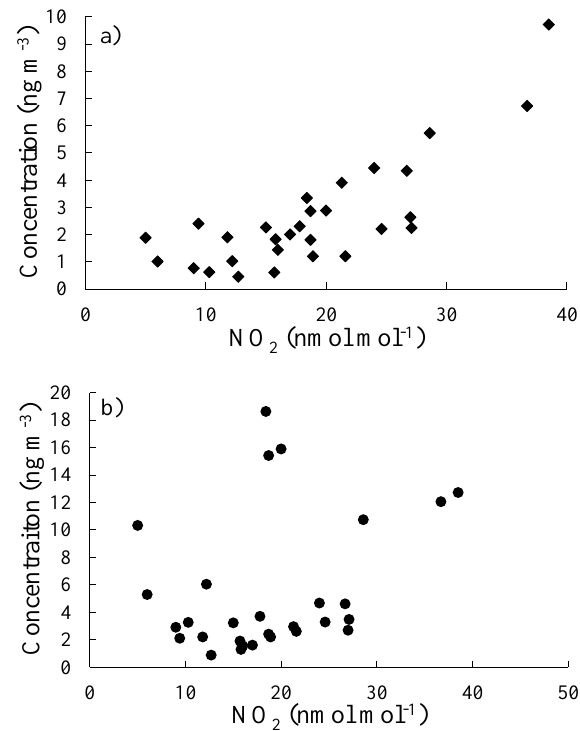
Figure 9. Plot of gas + PM sample concentrations of 2-methyl-4- nitrophenol (a) and 4-nitrophenol (b) vs. NO 2 mixing ratios, which are hourly data averaged over the sampling time for each filter sam- ple from the Ontario Ministry of the Environment historical pollu- tant data, Toronto West